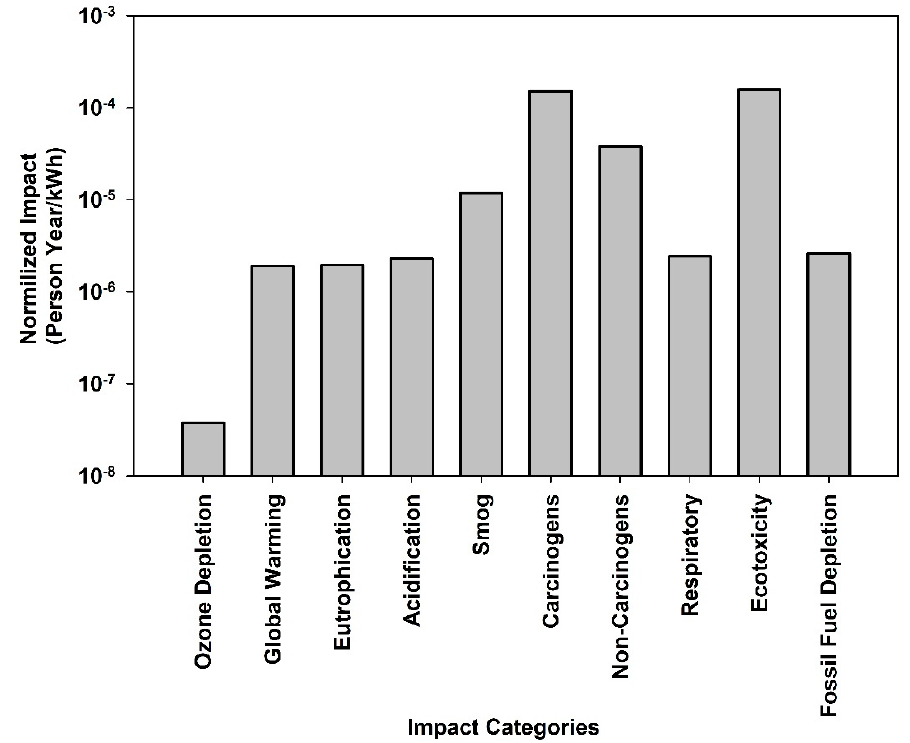
Figure 6. Normalized Impact plot based on US 2008 impact per person-year.